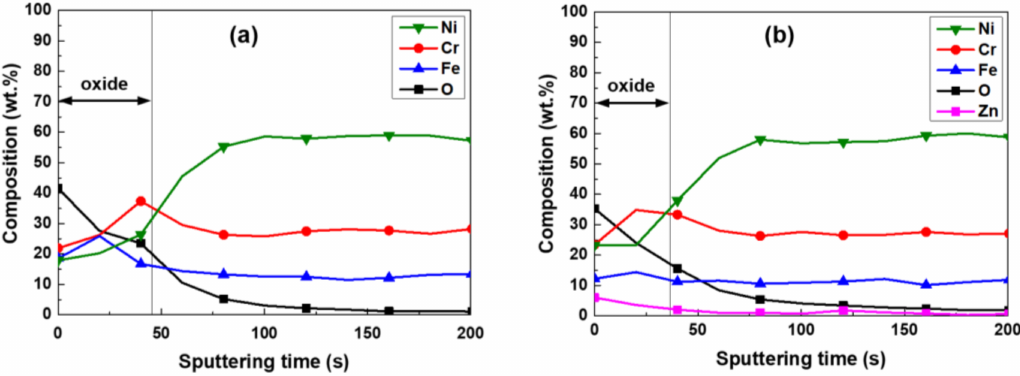
Figure 9. XPS depth profiles of oxides grown on Alloy 690 in 2 ppm Li + 1000 ppm B solution ( a ) without (Case #1) and ( b ) with 60 ppb Zn (Case